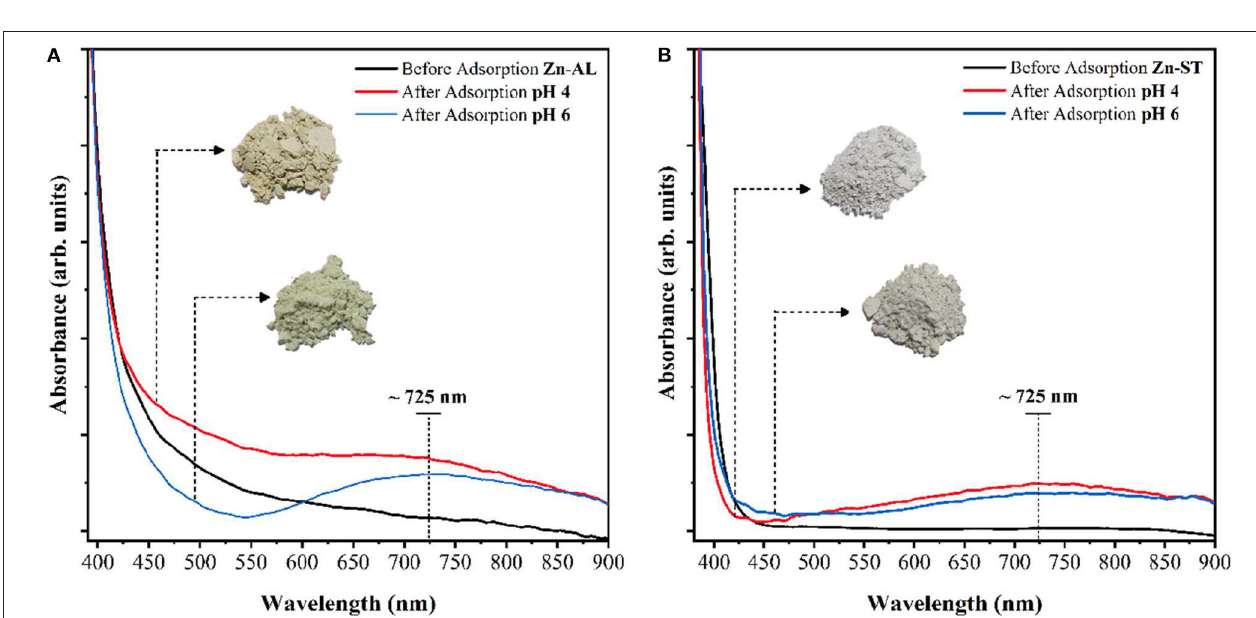
FIGURE 13 | Electronic absorption spectra (visible) of ZnO before the adsorption of copper solution 50mg L − 1 , pH 4 and 6: (A) Zn-AL and (B) Zn-ST.